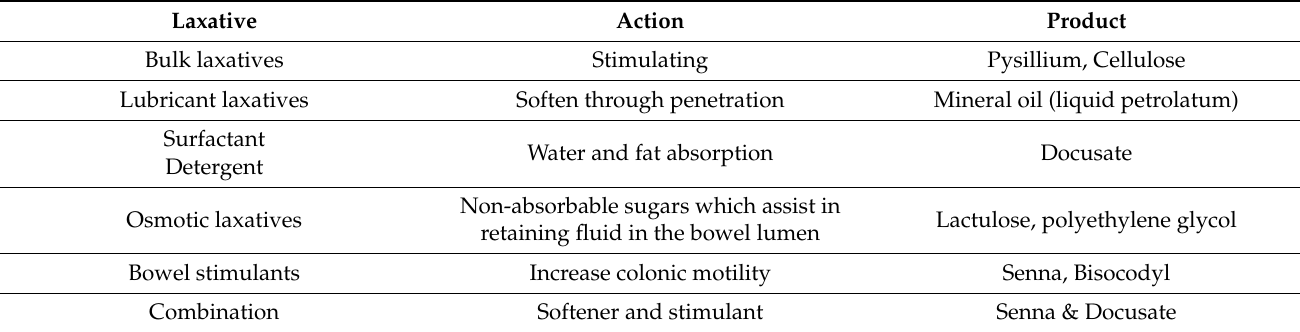
Table 1. Laxative